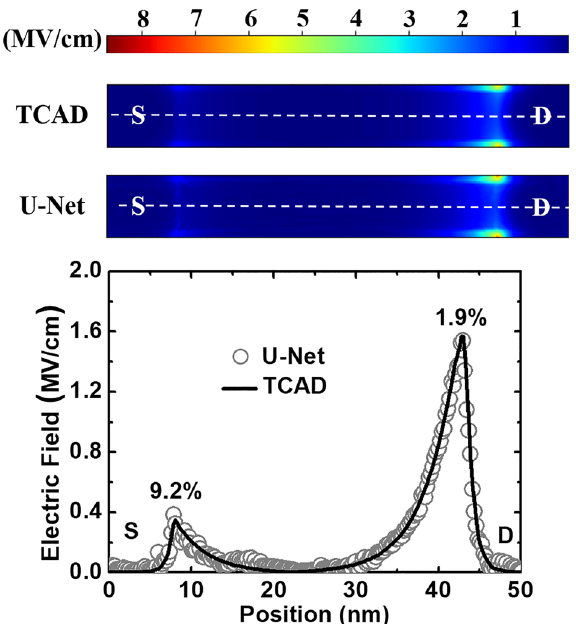
Figure 6. Comparisons between electric field extracted from TCAD simulations and deduced from the electrostatic potential contour predicted by U-Net at V DS = 0.6 V and V GS = 0.29 V. The 1D profile (bottom) is extracted from the 2D landscapes (upper) along the dashed lines. The errors of the maximum values at the source and drain junctions are about 9.2 and 1.9%, respectively.